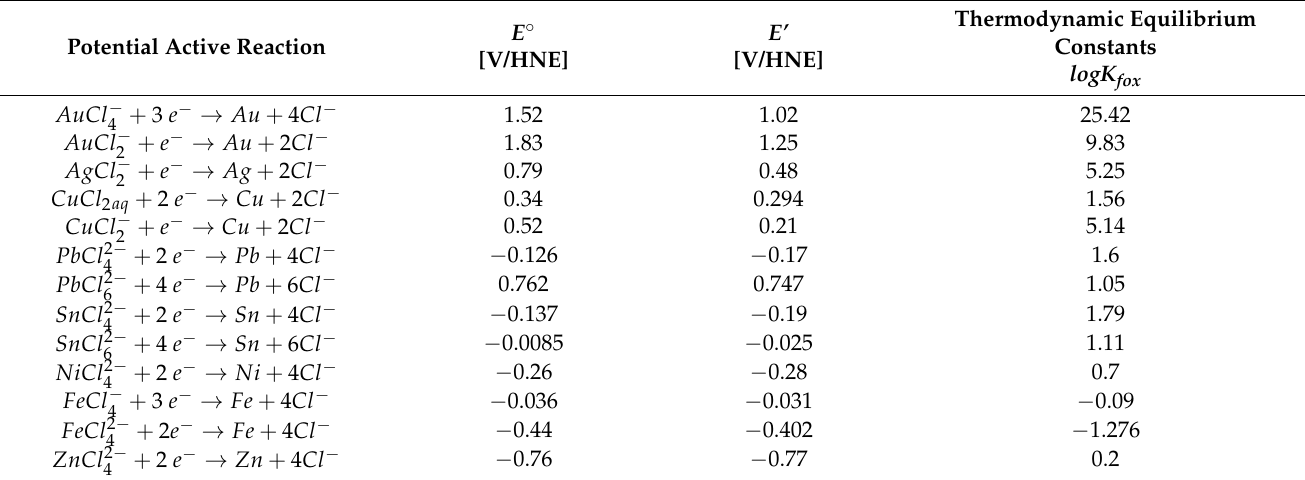
Table 3. E ’ values for the involved potential active reaction.